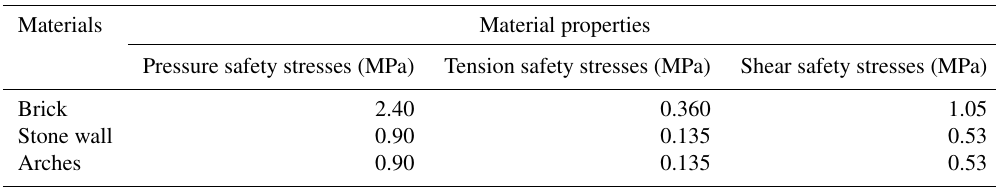
Table 2. Safety stresses of materials.